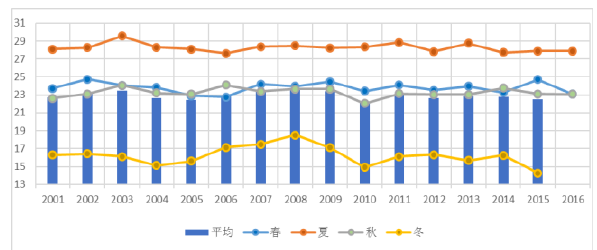
human activity the LST in low altitude regions are